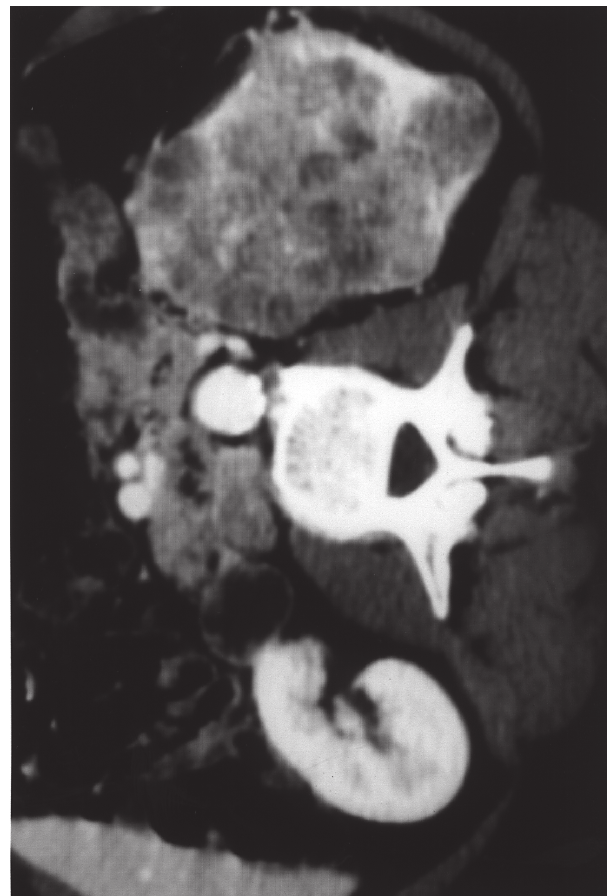
Figure 2 - Computed tomography of the abdomen revealed a large solid mass involving the inferior pole and mid portion of left kidney, infiltrating the perirenal fat, and in close contact with the psoas